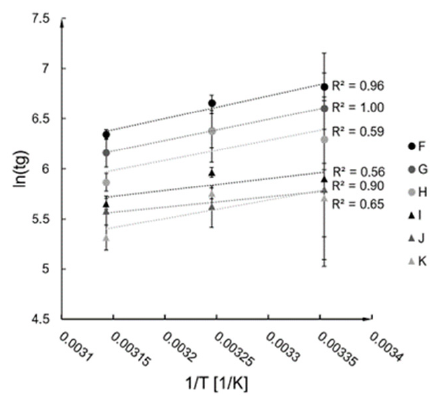
Figure 2. Dependence of gelation time on temperature.